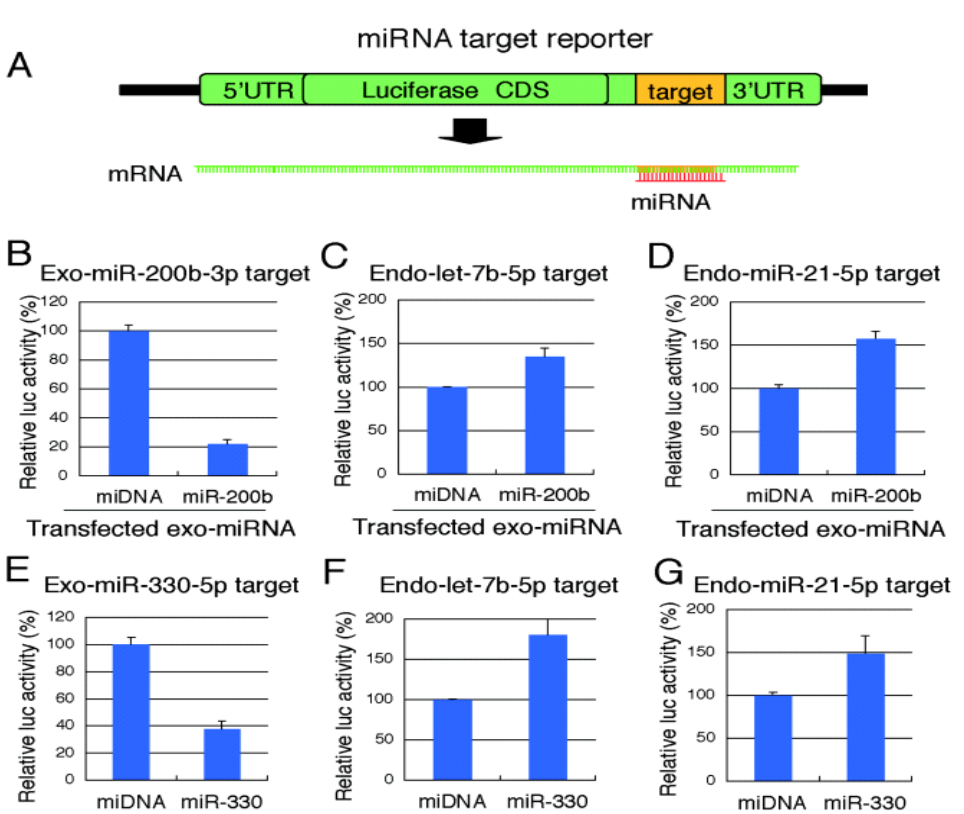
Figure 4. Luciferase reporter analyses of changes in the expression of exo-miRNA and endo-miRNA targets. ( A ) Schematic structure of a luciferase reporter containing a miRNA completely matched target sequence in the 3' UTR and mRNA transcribed from the reporter. The exo-miRNAs, miR-200b ( B – D ) and miR-330 ( E – G ), respectively, were transfected into HeLa cells at 50 nM. At 24 h post-transfection, luciferase activities were measured. The luciferase activities derived from the constructs carrying exo-miRNA target sequences were decreased by the transfection of respective exo-miRNA ( B , E ). In contrast, the luciferase activities from the constructs carrying endo-let-7b-5p ( C ), endo-miR-21-5p ( D , G ) and endo-miR-7b-5p ( F ) target sequences were increased, indicating that exo-miRNAs repressed endo-miRNA silencing